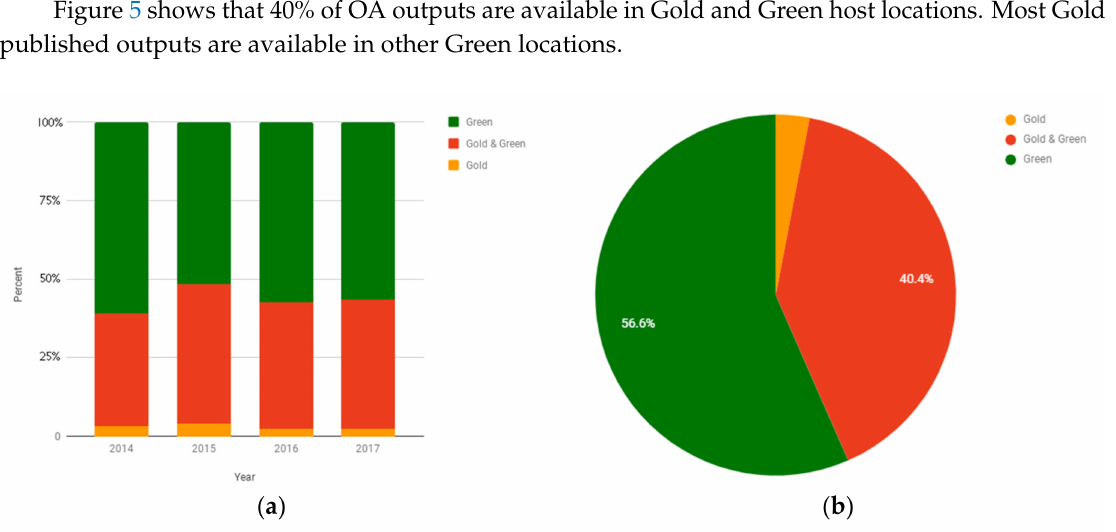
Figure 5. The enhanced publication dataset (‘All location’ classification) 2014–2017, ( a ) Brunel OA dissemination by year (percentages on publication); ( b ) Brunel OA dissemination 2014–2017 (percentages on